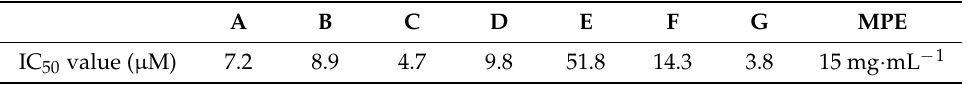
Table 2. In vitro cytotoxic effect of MPE, MPPs and oleanolic acid on A549